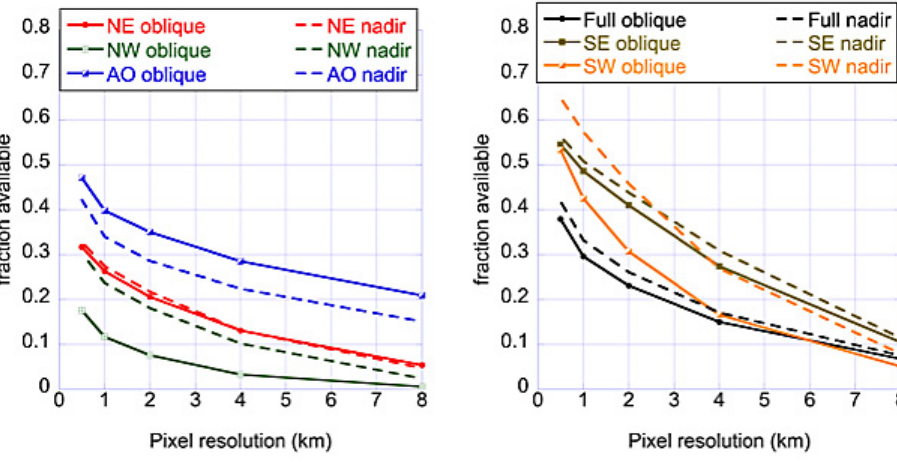
Fig. 7. Calculated availability of aerosol retrieval as a function of instrument pixel size for the full domain and subdomains defined in Fig. 5, for the spring season, and separated into oblique angles with sensor view angle greater than 50 ◦ (solid lines) and nadir angles with sensor view less than 20 ◦ (dashed lines). The six domains analyzed are presented in two panels for visual clarity. Table 4. Seasonal mean aerosol retrieval availabilities and cloud fraction for the full domain and subdomains during spring (MAM), divided into nadir views (sensor view angle < 20 ◦ ) and oblique views (sensor view angle > 50 ◦ ) . Cloud fraction is for the native nominal resolution of MODIS, 0 . 5 × 0 . 5km at